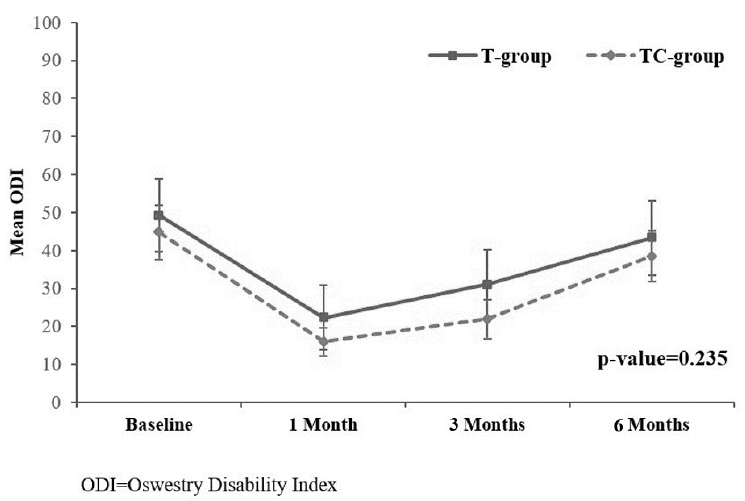
Figure 5. Average Oswestry Low Back Pain Disability Index: between-group comparison (Line graph is presented with mean and 95%CI error bars) T group = transforaminal, TC group = transforaminal and caudal.